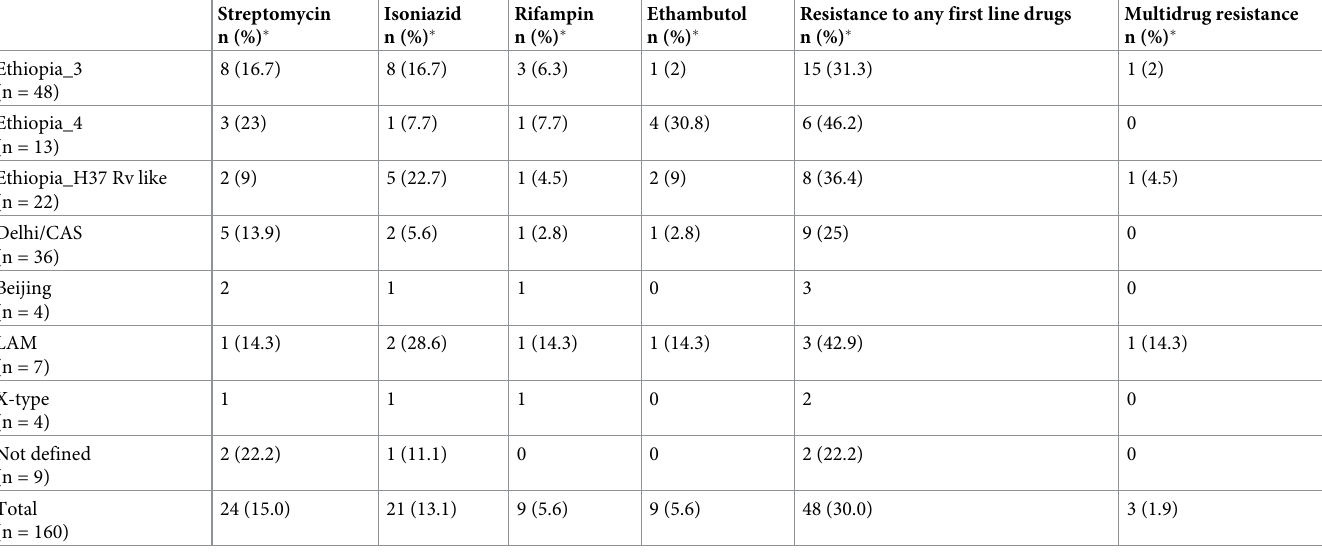
(cid:3) Percentage calculated from the total number of isolates in each sub-lineage (n) and for those sub-lineages with more than 5 strains; MDR: Multi Drug Resistance; n = number of resistance strains in the specific